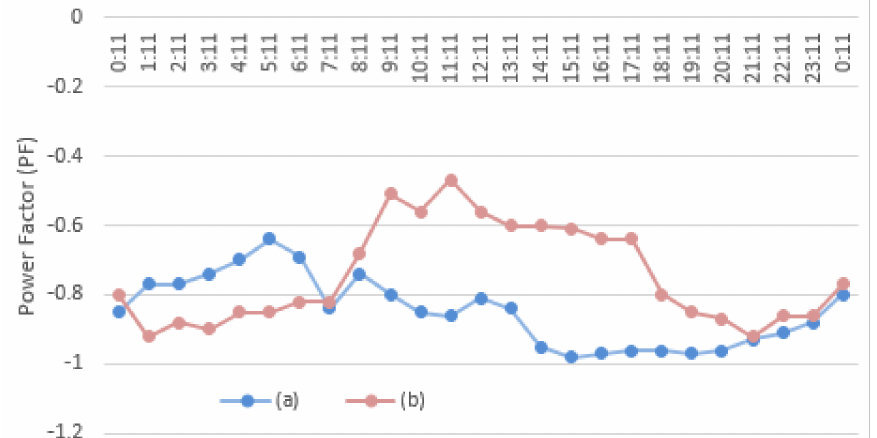
Figure 9. Transformer power factor (PF) on: ( a ) weekdays; and ( b ) holidays (positive values indicate inductive PF, whereas negative values mean capacitive